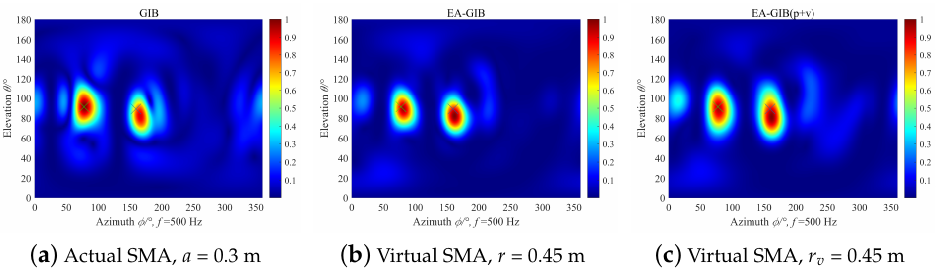
Figure 13. Experiment data processing results of the double sound source with the frequency 500